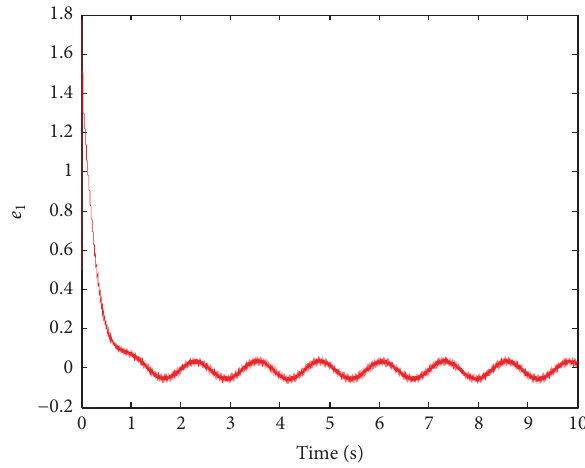
Figure 8: Tracking error 𝑒 1 of input signal 1.